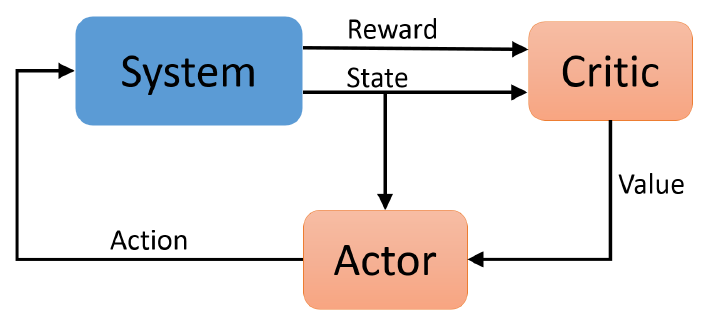
Figure 8. A high-level block diagram of the actor-critic reinforcement learning architecture is